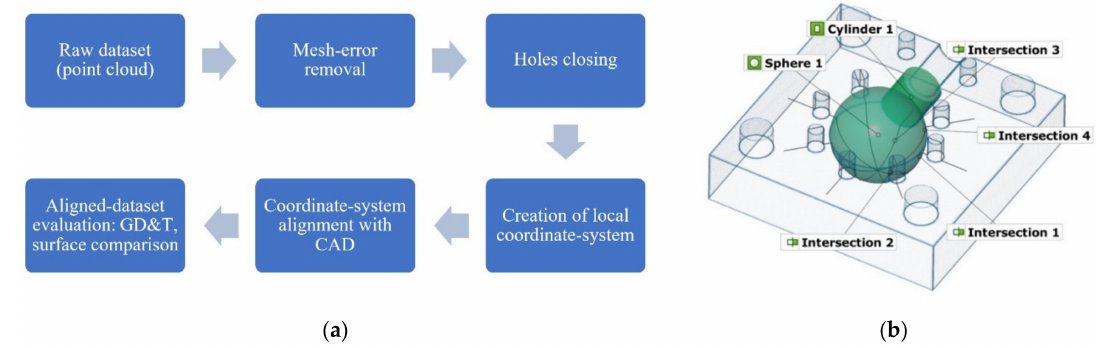
Figure 7. ( a ) Schematic view of the evaluation flow; ( b ) visualization of the measured geometries.